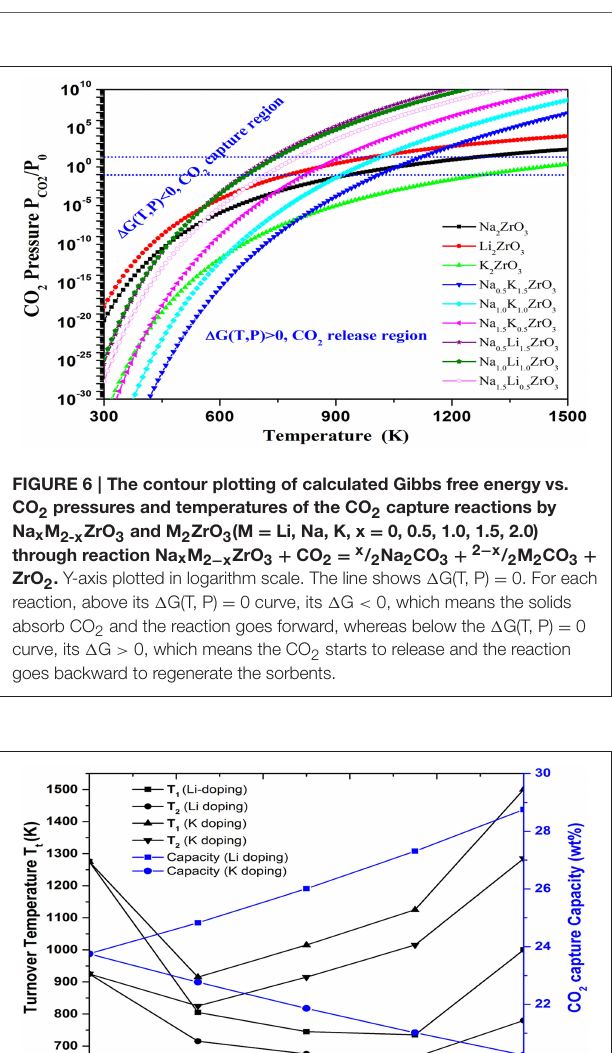
Figures 6 , 7 , the Na 2 − x Li x ZrO 3 and Na 2 − x K x ZrO 3